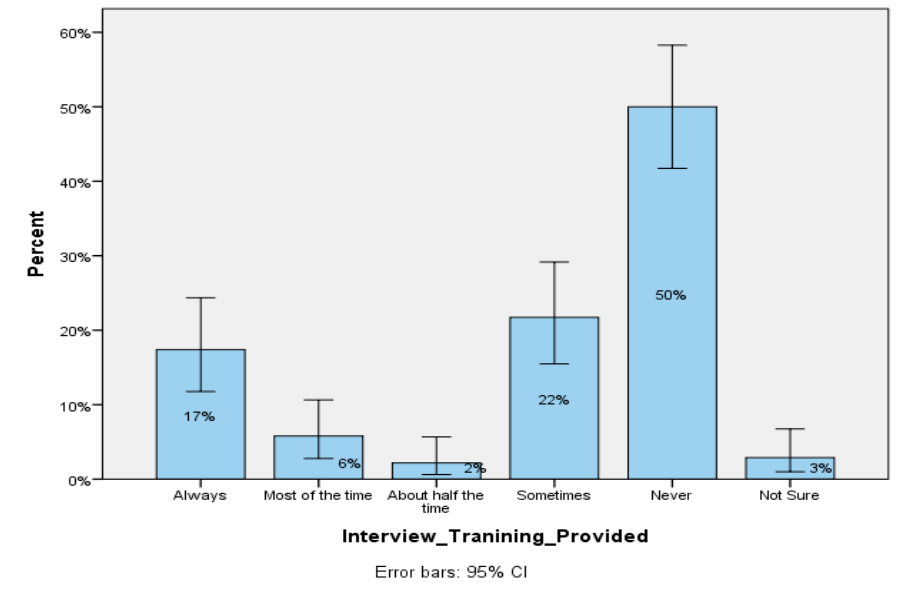
Figure 5. Interview Training by organisation.